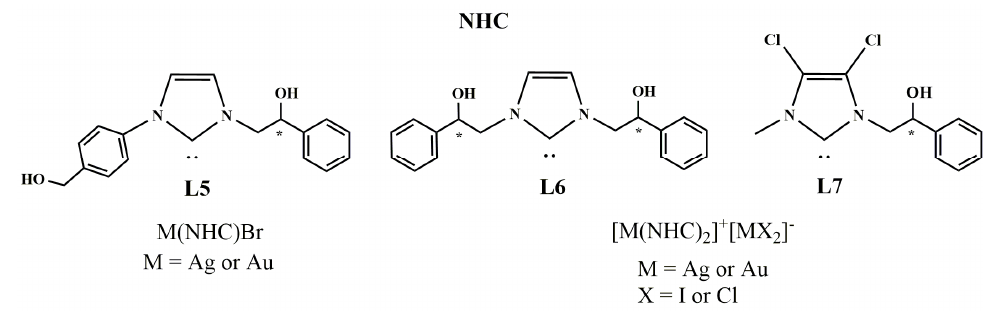
Figure 2. New synthetized Ag and Au complexes.